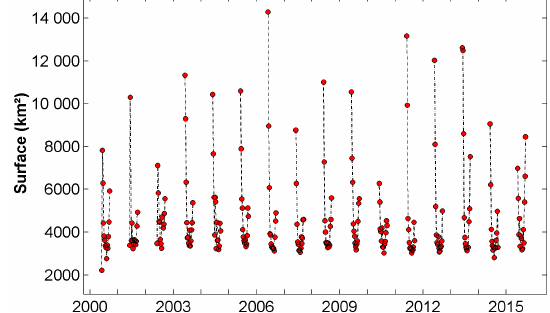
24 altimetry virtual stations were built at the cross section of an altimetry track with a water body for these three mis- sions respectively (see Fig. 5 for their locations). A water level temporal series is obtained for each virtual